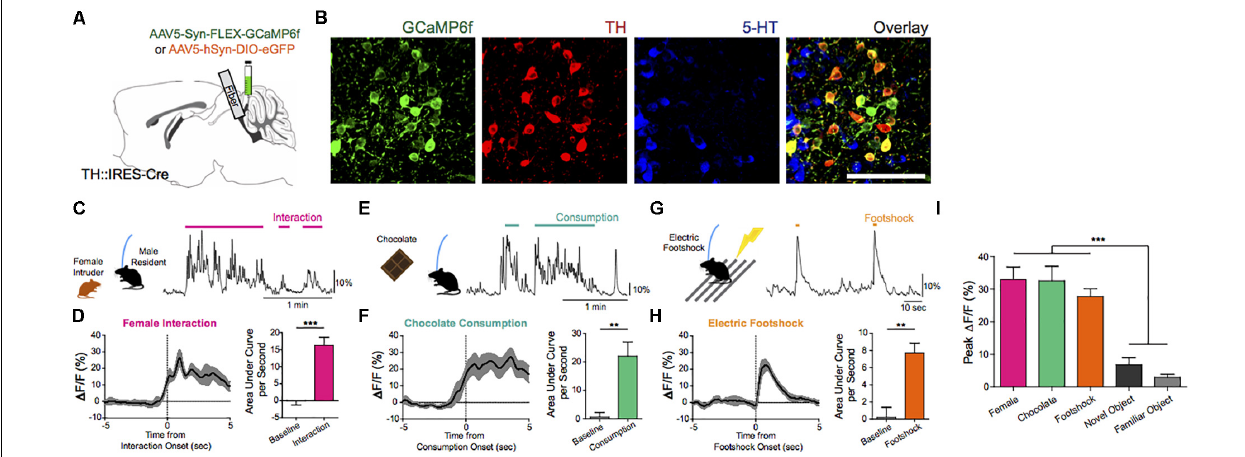
FIGURE 7 | Endogenous and optogenetically driven DRN DA firing. (A) TH-Cre mice were injected with AAV5-Syn-FLEX-GCaMP6f or AAV5-hSyn-DIO-EGFP and implanted with an optical fiber into the DRN for fiber photometry. (B) Confocal images of GCaMP6f + (green) neurons show co-localization with TH + neurons (red), but no overlap with 5-HT + neurons (blue). Scale bar, 100 µ m. (C) Social interaction between a male DRN DA - GCaMP6f resident mouse and a female intruder were associated with increased DRNDA activity; the trace is a representative recording with interaction bouts indicated. (D) Left: female interaction caused an increase in fluorescence at the onset (first interactions only). Right: quantification of the area under the curve per second (AUC) during the interaction (0–5 s) shows that social interaction caused significant increase in DRNDA activity from baseline ( − 5 to 0 s) ( n = 7 DRN DA - GCaMP6f mice; paired t test, t6 = 11.97, ∗∗∗ p < 0.001). (E) Chocolate consumption by a DRN DA - GCaMP6f mouse increased DRNDA activity; representative recording. (F) Left: DRNDA activity was increased upon chocolate consumption. Right: AUC quantification during consumption (0–5 s) compared with baseline ( − 5 to 0 s) shows that food consumption is associated with significant fluorescence increase ( n = 7 DRN DA - GCaMP6f mice; paired t test, t6 = 4.273, ∗∗ p < 0.01). (G) Electric footshocks (0.25 mA, 1 s) were delivered; representative DRNDA trace during two consecutive footshocks. (H) Left: footshock induced phasic DRN DA activation. Right: DRN DA activity after footshock (0–5 s) was significantly increased relative to baseline ( − 5 to 0 s) ( n = 7 DRN DA - GCaMP6f mice; paired t test, t6 = 5.763, ∗∗ p < 0.01). (I) Peak DRNDA fluorescence values during female interaction, chocolate consumption, and electric footshocks were significantly higher than those during novel and familiar object interaction ( n = 7 DRN DA - GCaMP6f mice; one-way ANOVA,